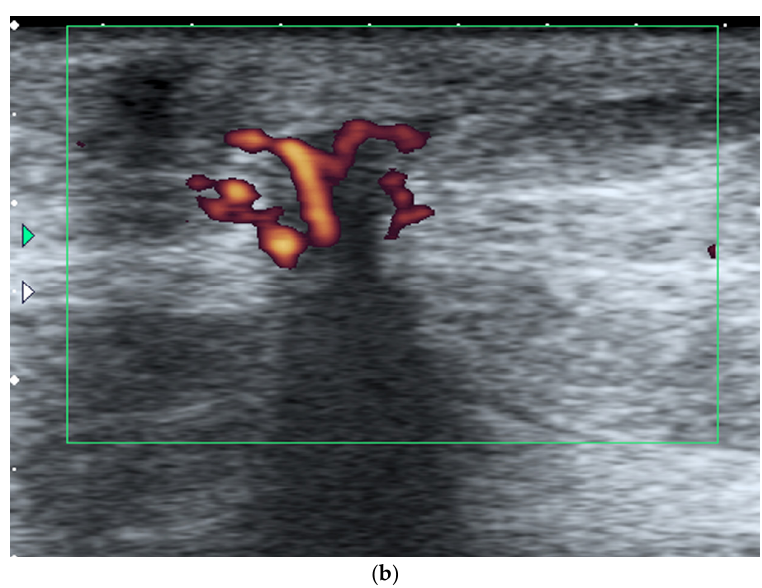
Figure 13. Screening routine right CC mammogram in a 60 year-old patient ( a ). The right CC mammogram demonstrates a small irregular spiculated mass in the retroareolar area (arrow). US images of the right breast show an ( b ); irregular spiculated non-parallel hypoechoic mass associated with an increased vascularity at color Doppler interrogation. Pathology yielded low-grade invasive ductal carcinoma.